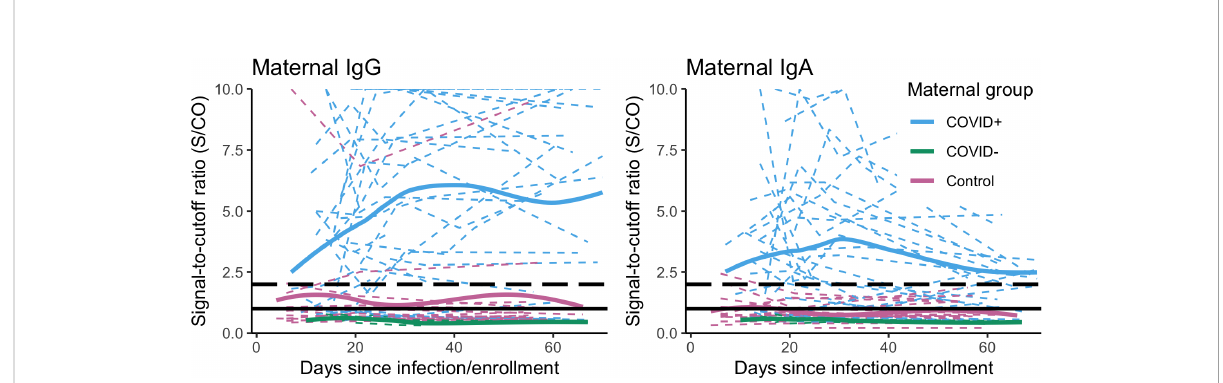
FIGURE 1 Individual maternal IgG and IgA S/CO trajectories (dashed, colored lines) over two months following maternal infection onset or enrollment, and loess smooth curves (solid, colored lines) fi t for each enrollment group: COVID+ (n = 36, n obs = 116); COVID- (n = 6, n obs = 18); BF control group, (n = 20, n obs = 50, excluding samples collected post-vaccination). S/CO=1.0 (solid black line), S/CO=2.0 (dashed black line). Y-axis is truncated at S/CO = 10; samples with S/CO between 10-20 not shown (IgG n subj = 12, n obs = 19; IgA n subj = 6, n obs = 4).